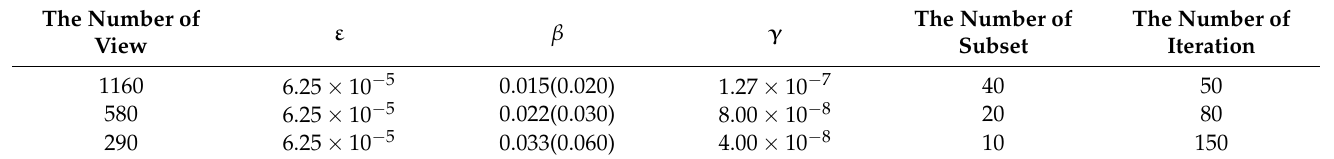
Table 2. Selection of parameters of SIRDL + HL algorithm for normal (low)-dose sheep lung data.